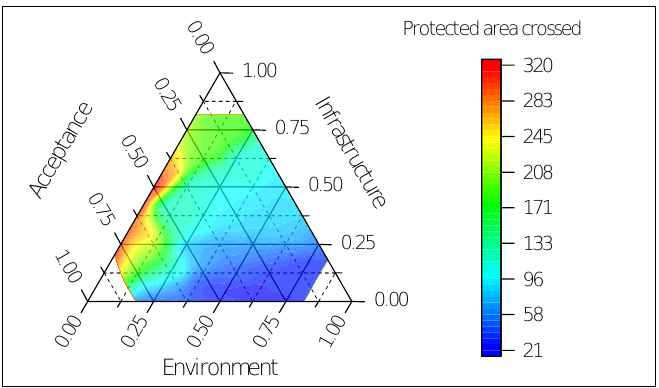
Figure 8. Influence of different weighting factors on the protected areas crossed for the DC GER project. Own